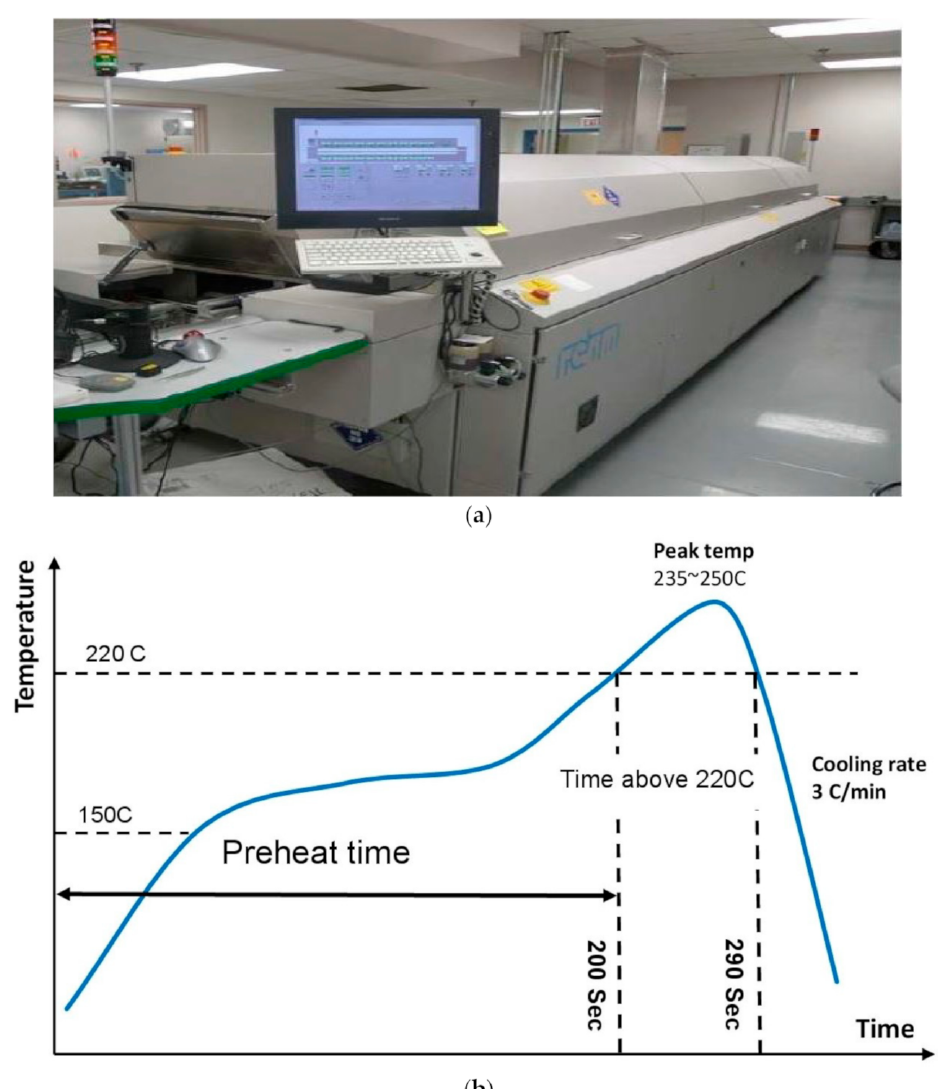
Figure 3. Schematic figure of ( a ) Reflow oven; and ( b ) Reflow